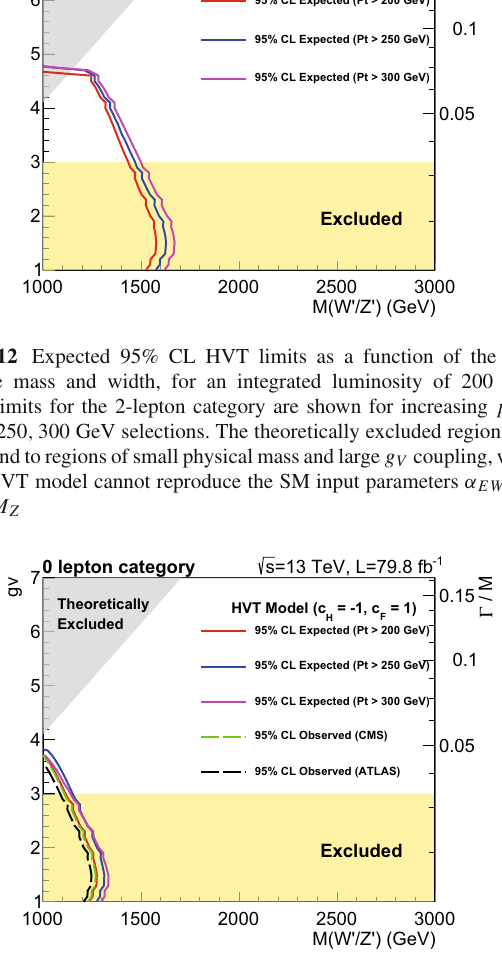
Fig. 11 Expected 95% CL HVT limits as a function of the reso- nance mass and width, for an integrated luminosity of 200 fb − 1 . The limits for the 1-lepton category are shown for increasing p ⊥ > 200 , 250 , 300 GeV selections. The theoretically excluded regions cor- respond to regions of small physical mass and large g V coupling, where the HVT model cannot reproduce the SM input parameters α EW , G F and M Z